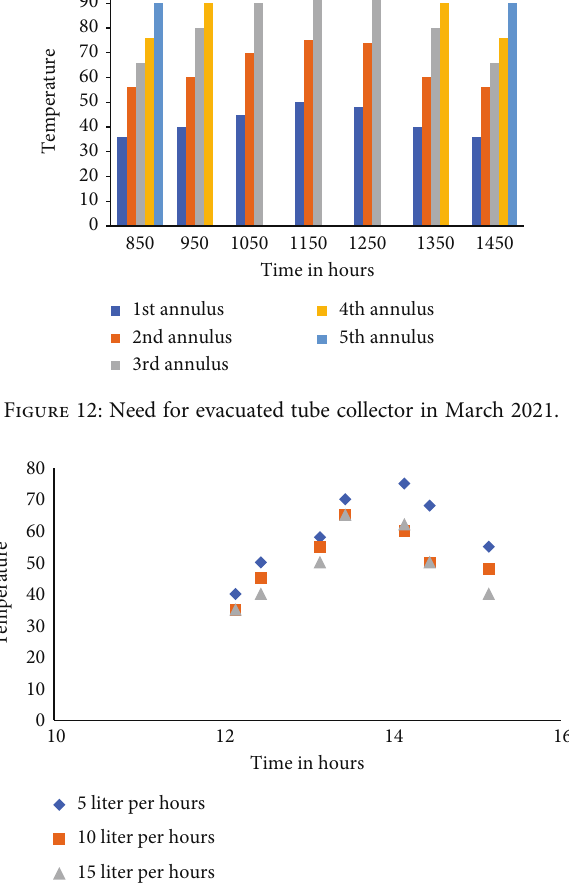
Figure 13: Various fl ow rates computation of milk temperature variation.